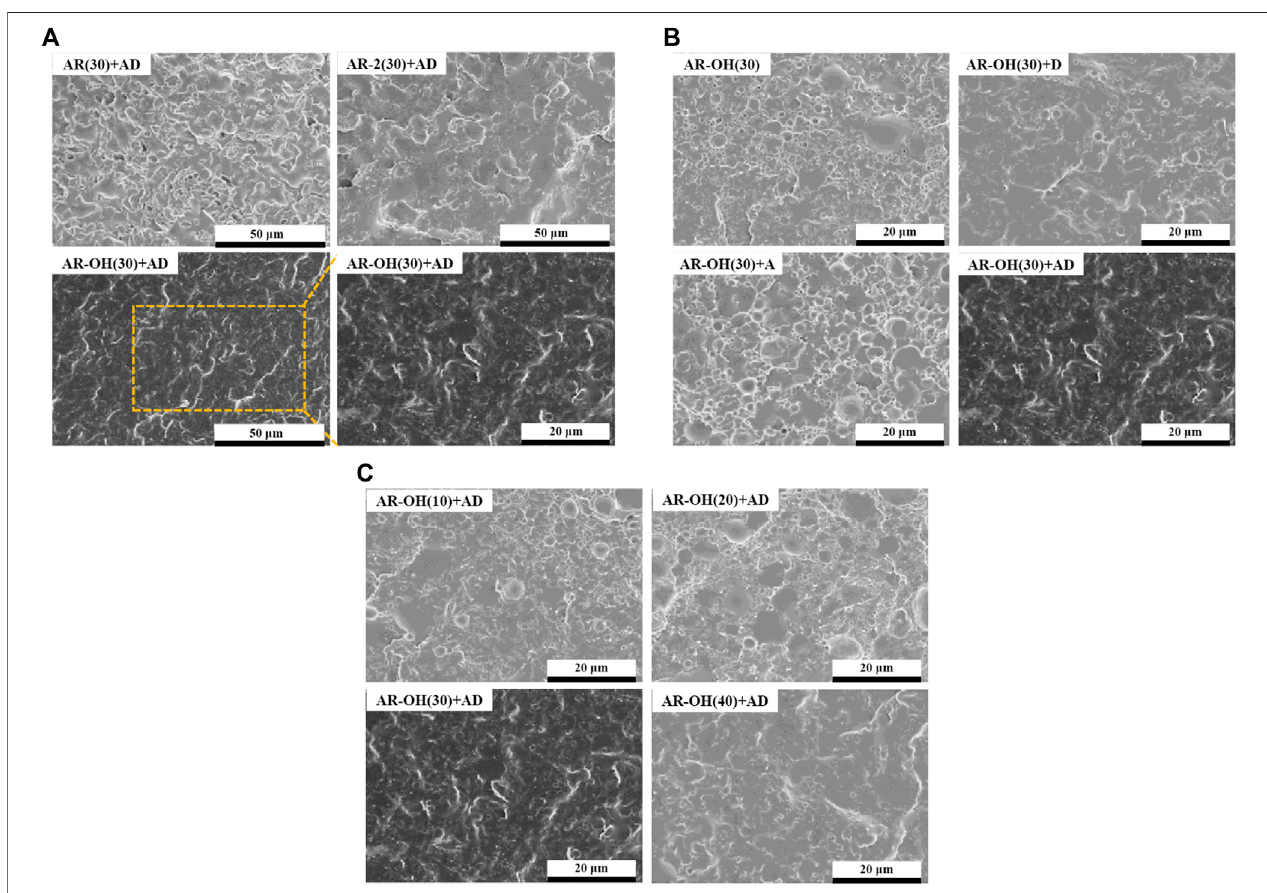
FIGURE4| SEMmicrographsofthecryofracturedsurfacesofthePLA/ i -BIIRsblends. (A) neatPLAandPLA/ i -BIIRsblendswithADRandDCPaddedand30 wt%content of ionomer, (B) neat PLA and PLA/ i -BIIR-OH blends with different addition of ADR and DCP, (C) neat PLA and PLA/ i -BIIR-OH blends with different ionomer content.